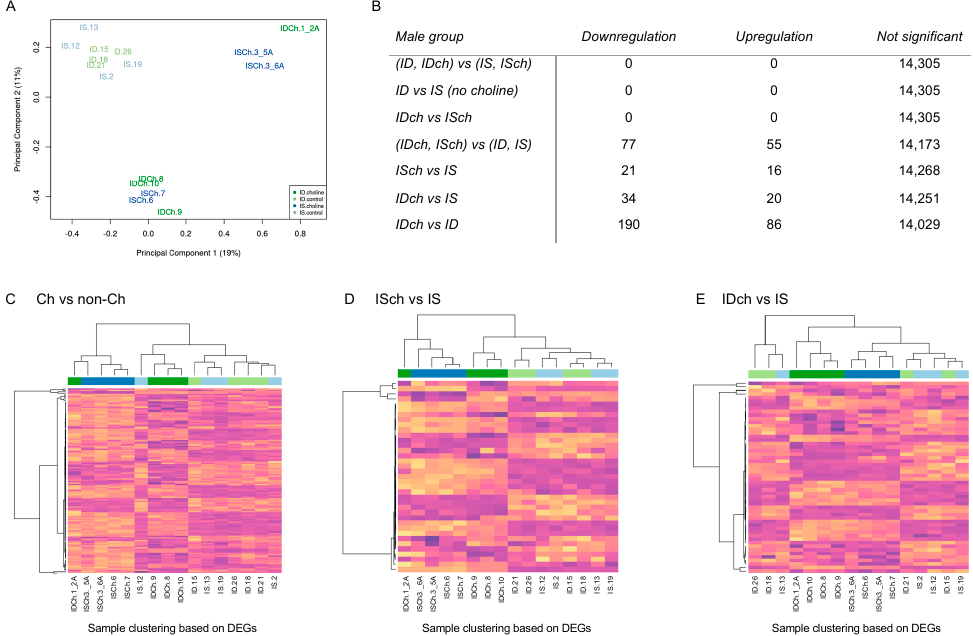
Figure 3. Effects of choline supplementation and ID on the male hippocampal transcriptome. ( A ) Multidimensional plot showing that the sources of variation among samples do not correspond with either iron status or choline treatment. Choline supplementation seems to have a stronger effect than an iron status on gene expression profiles as choline non − treated samples clustered together. ( B ) The table shows gene expression changes among comparison groups with the most affected in the IDch vs. ID comparison. ( C – E ) Heatmaps from DE genes among comparison groups show clear clustering among choline ‐ treated IS samples but less clear in the ID samples. Each bar represents gene expression in CPM, with purple being the lowest expression value and yellow being the highest. Blue and green bars at the top indicate the group assignment.